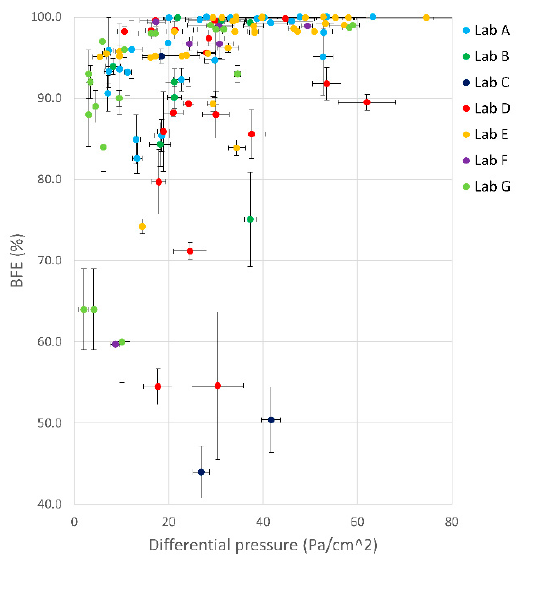
( a ) ( b ) Figure 9. Variability of BFE and DP measurements among the five samples of each mask model/prototype tested by the whole laboratory network ( a ) BFE vs. DP data showing standard deviations as error bars in a subset of data; ( b ) relative variability (error percentages over five measurements) on BFE vs. relative variability of DP measurements in the whole mask dataset.